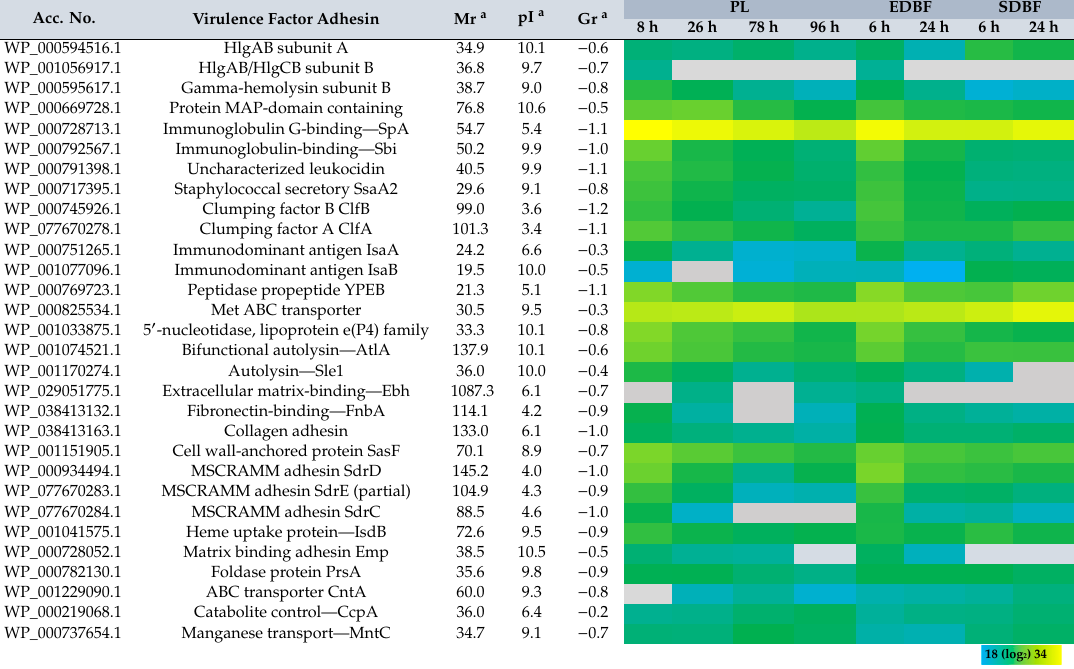
Table 1. Abundance patterns of selected classical surface proteins on planktonic and biofilm cells.